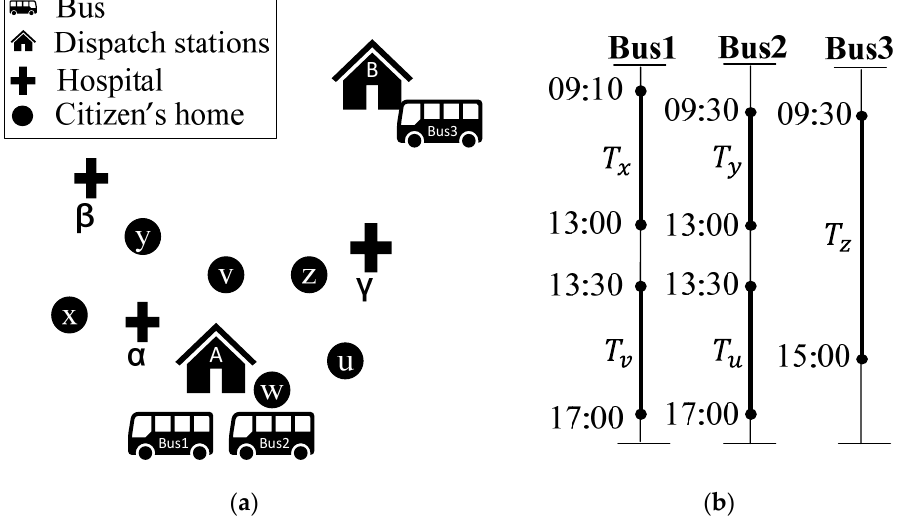
Figure 1. ( a ) City map including locations of dispatch stations, hospitals, and citizen’s house (note that station A has one bus and station B has 2 buses). ( b ) Timeline of the fleet where T_x represents the time period that bus1 is occupied by the citizen x.